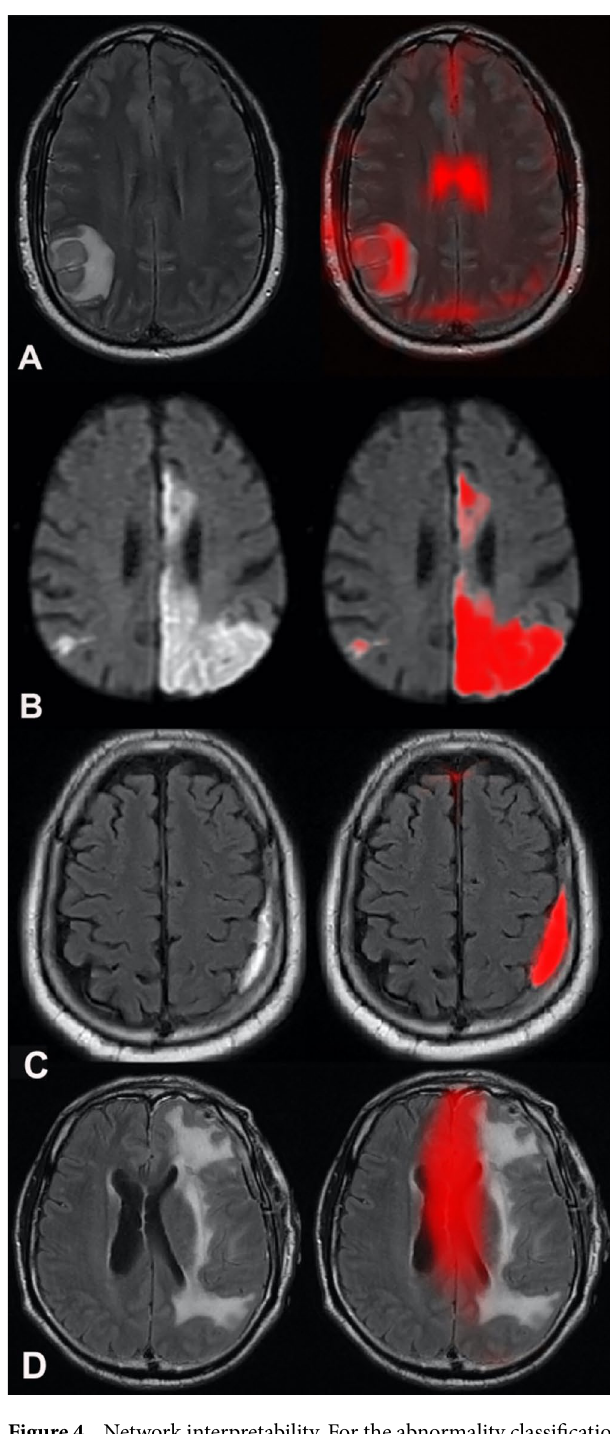
Figure 4. Network interpretability. For the abnormality classification, a heat map can be generated retrospectively denoting regions that strongly influenced the decision: ( A ). For critical findings, the network directly generates heat maps of denoting the region identified by the AI: acute infarction on a trace-weighted contrast ( B ), subdural hemorrhage on a FLAIR contrast ( C ) and mass effect on a FLAIR contrast ( D